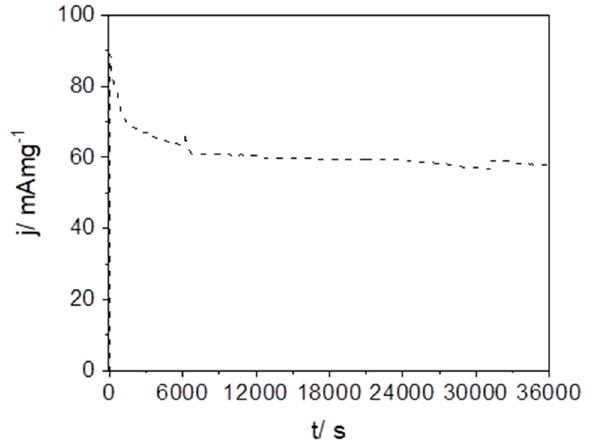
Figure 11. Stability study of Ir-Sn-Sb-O catalyst in single cell at 1.8 V and 60 °C for a period of 10 h.